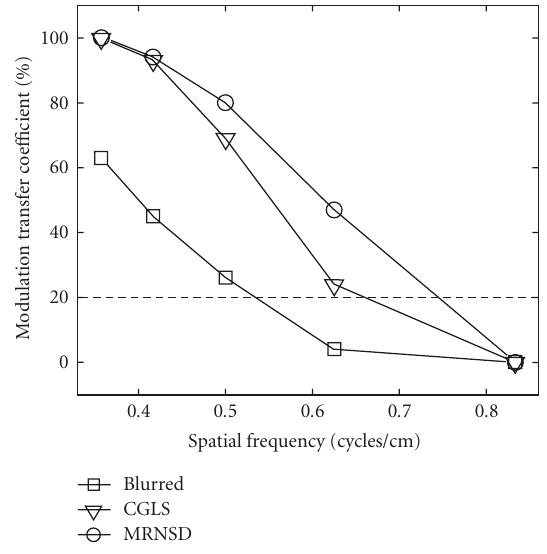
Figure 10: MTFs for blurred tomograms and restorations obtained with the use of unpreconditioned